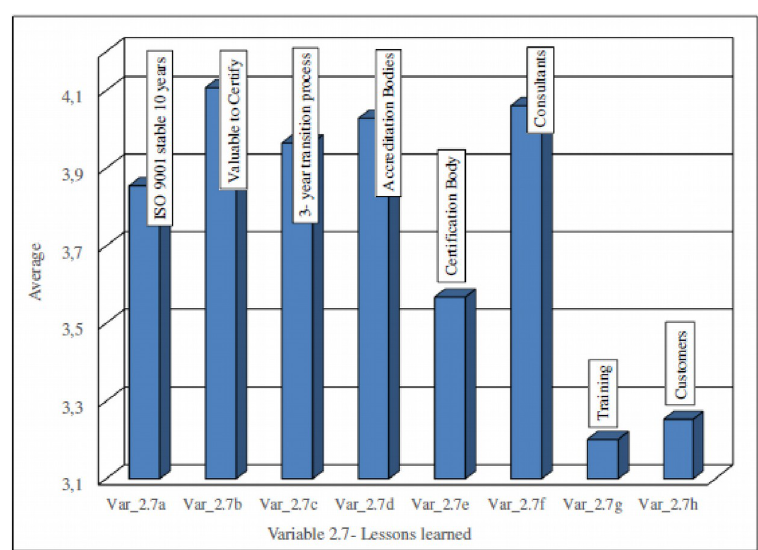
Figure 5. Average of the lessons learned with the implementation of the